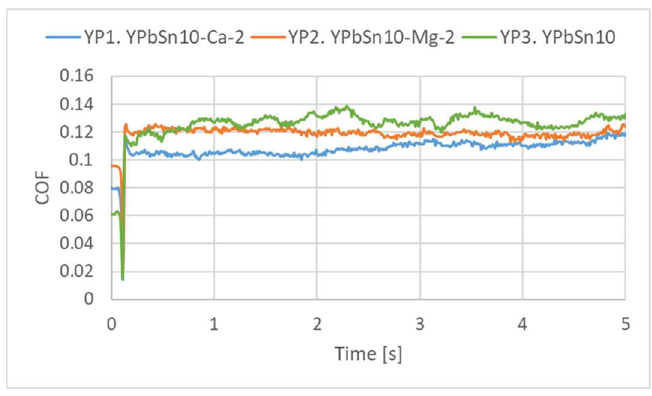
Figure 9. Variation in the COF during the 10 N, 1 mm/s tests.